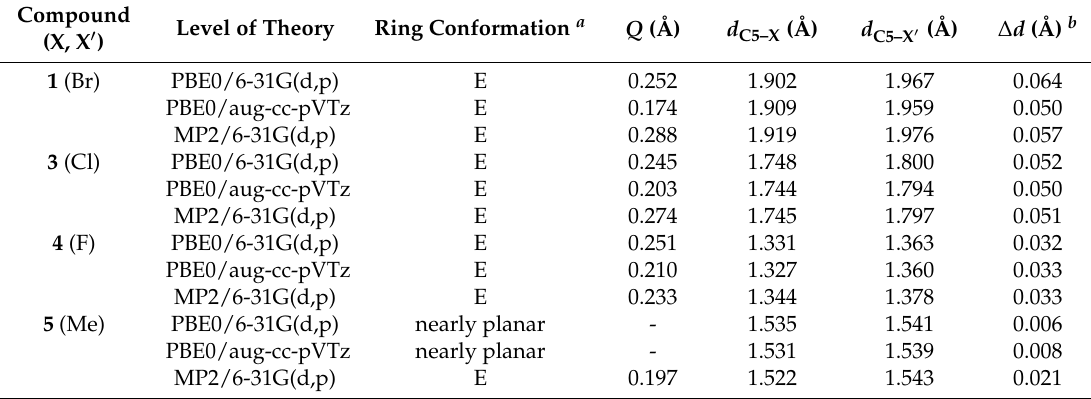
Table 5. Calculated parameters, conformation and puckering amplitudes Q [17] of pyrimidine rings and the corresponding equatorial ( d C5–X ) and axial ( d C5–X 1 ) bond distances at ring atom C5, derived from gas phase ab initio models for four 5,5-disubstituted barbituric acid analogues (X = X 1 = F, Cl, Br,